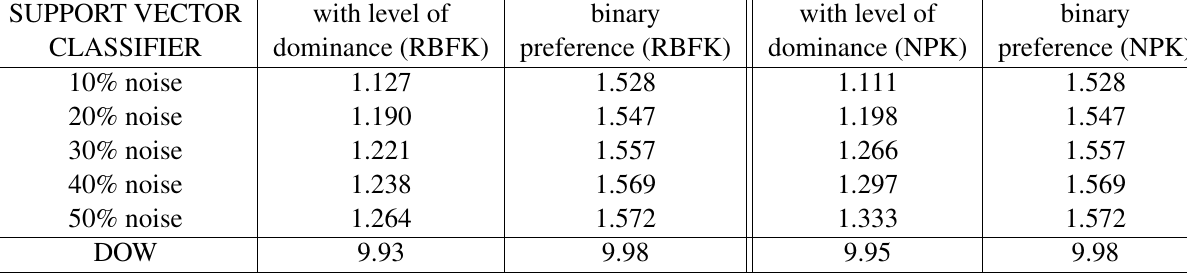
Table 1: Preference with level of dominance vs. binary preference — mean absolute error with support vector classifier with Radial Basis Function Kernel (RBFK) and Normalised PolyKernel (NPK) average gain in previous x trading RS =